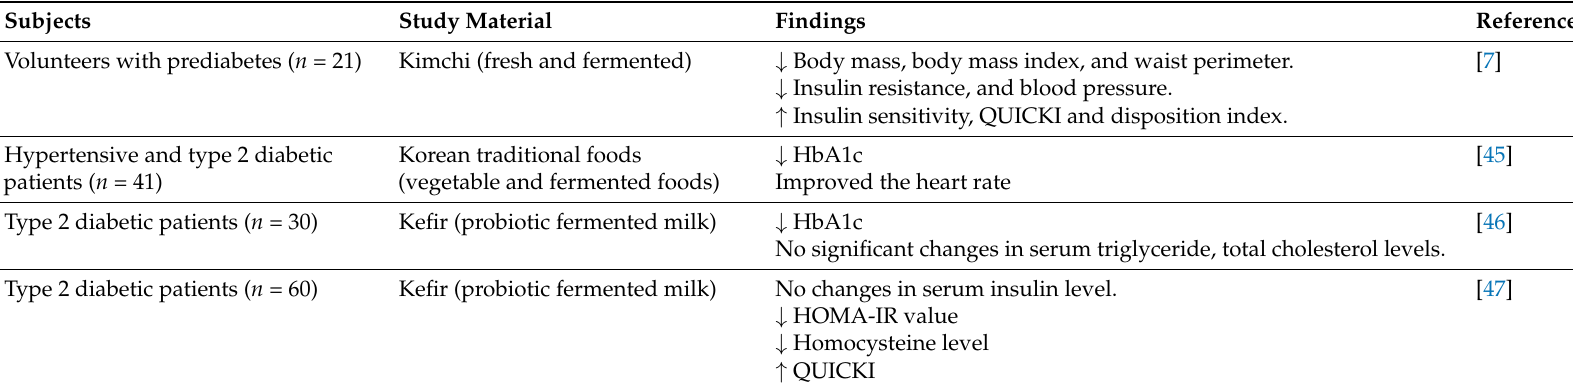
Table 3. Reported in vivo studies in humans revealing the antidiabetic properties of fermented